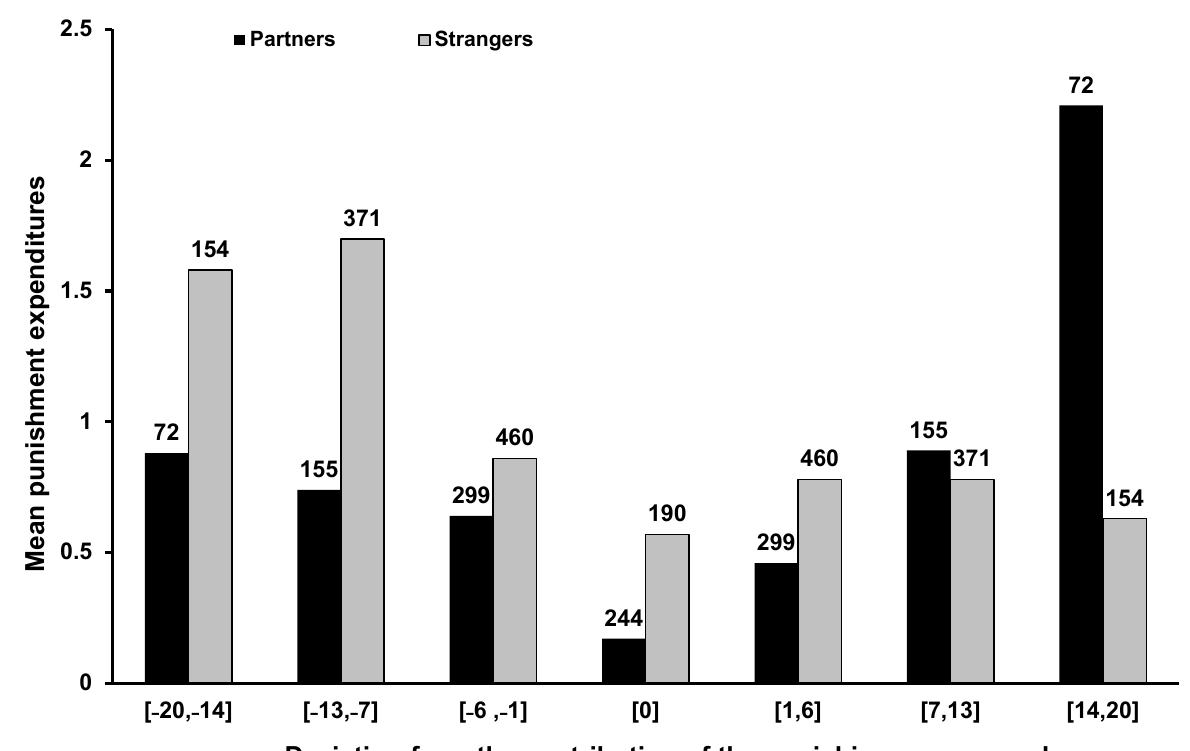
Figure 2. Mean expenditures on punishment (in points/round) as functions of the deviation of the contribution of the punished group member from the contribution of the punishing member. The bars corresponding to negative deviations depict mean points allocated to punish free riders, and the bars corresponding to non-negative deviations depict mean points allocated to antisocial punishment.